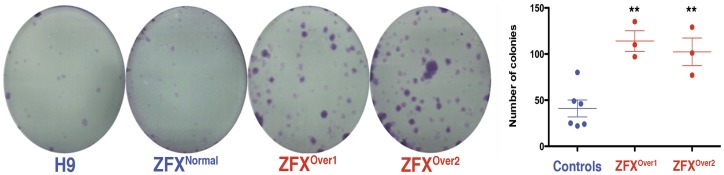
ZFXOver cultures have a higher clonogenic capacity.A. ZFXOver clones, ZFXNormal and H9 hESCs (together grouped as controls) were dissociated into single cells before clonal replating. Cells were expanded for 10 days before fixation and staining with crystal violet. B. Colony counts between ZFXOver and control hESCs in 3 independent experiments with error bars representing the S.E.M.